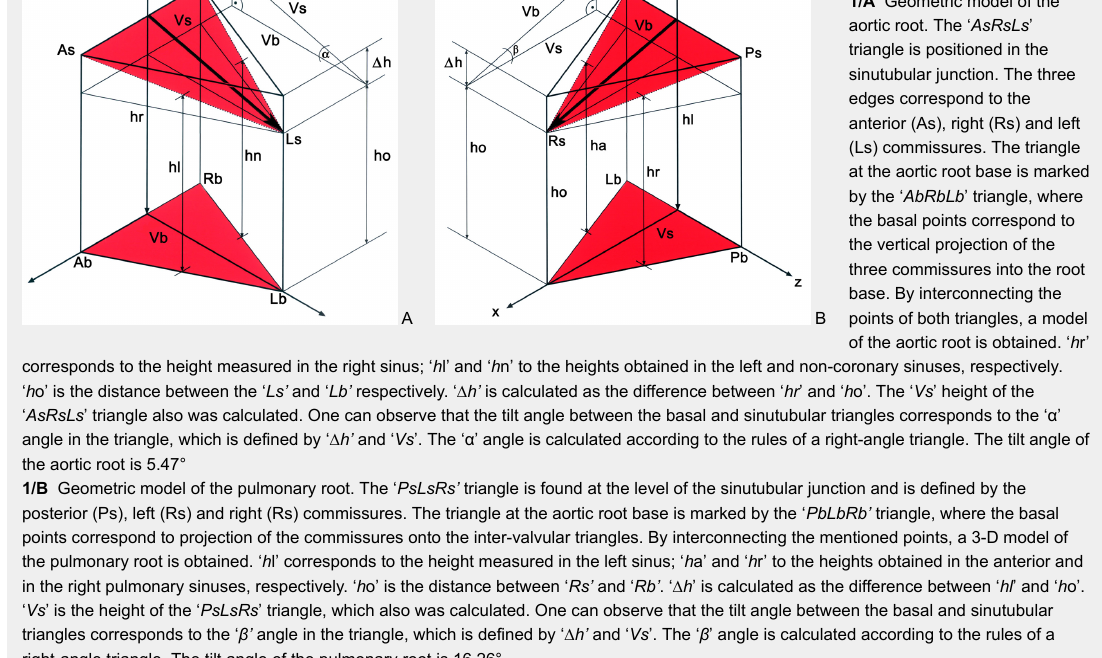
1/A Geometric model of the aortic root. The ‘ AsRsLs ’ triangle is positioned in the sinutubular junction. The three edges correspond to the anterior (As), right (Rs) and left (Ls) commissures. The triangle at the aortic root base is marked by the ‘ AbRbLb ’ triangle, where the basal points correspond to the vertical projection of the three commissures into the root base. By interconnecting the points of both triangles, a model of the aortic root is obtained. ‘ h r’